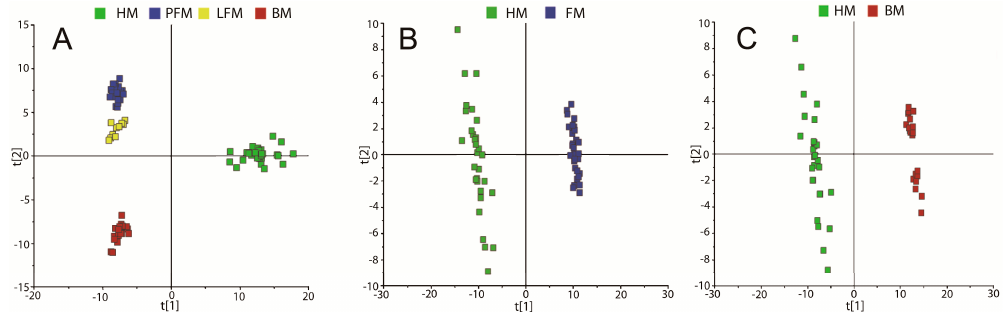
Figure 1. The scores plots of PLS-DA model constructed with annotated metabolites. ( A ) The scores plot of PLS-DA model discriminating HM, LFM, PFM and BM; ( B ) the scores plot of PLS-DA model discriminating HM and FM; ( C ) the scores plot of PLS-DA model discriminating HM and BM. Each component axis is denoted as t[x] on the score plots where x is the component number. HM, human breast milk; LFM, liquid formula milk; PFM, powdered formula milk; FM, formula milk; BM, bovine milk.